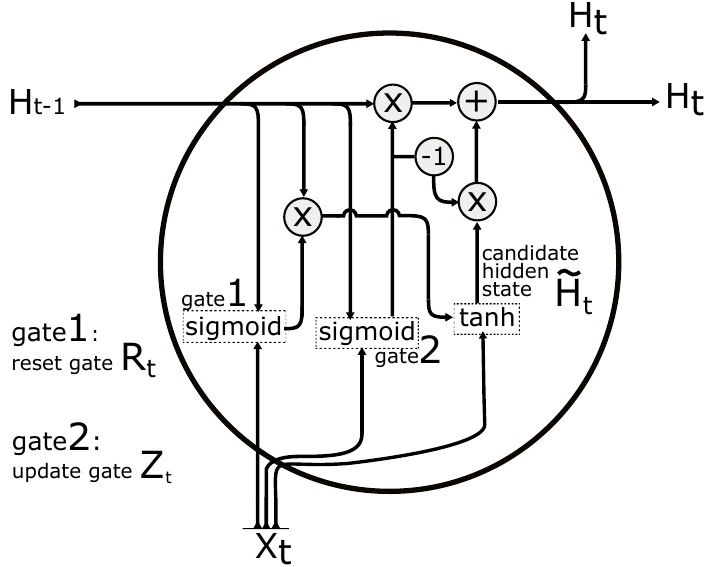
Figure 4. Structure of the GRU